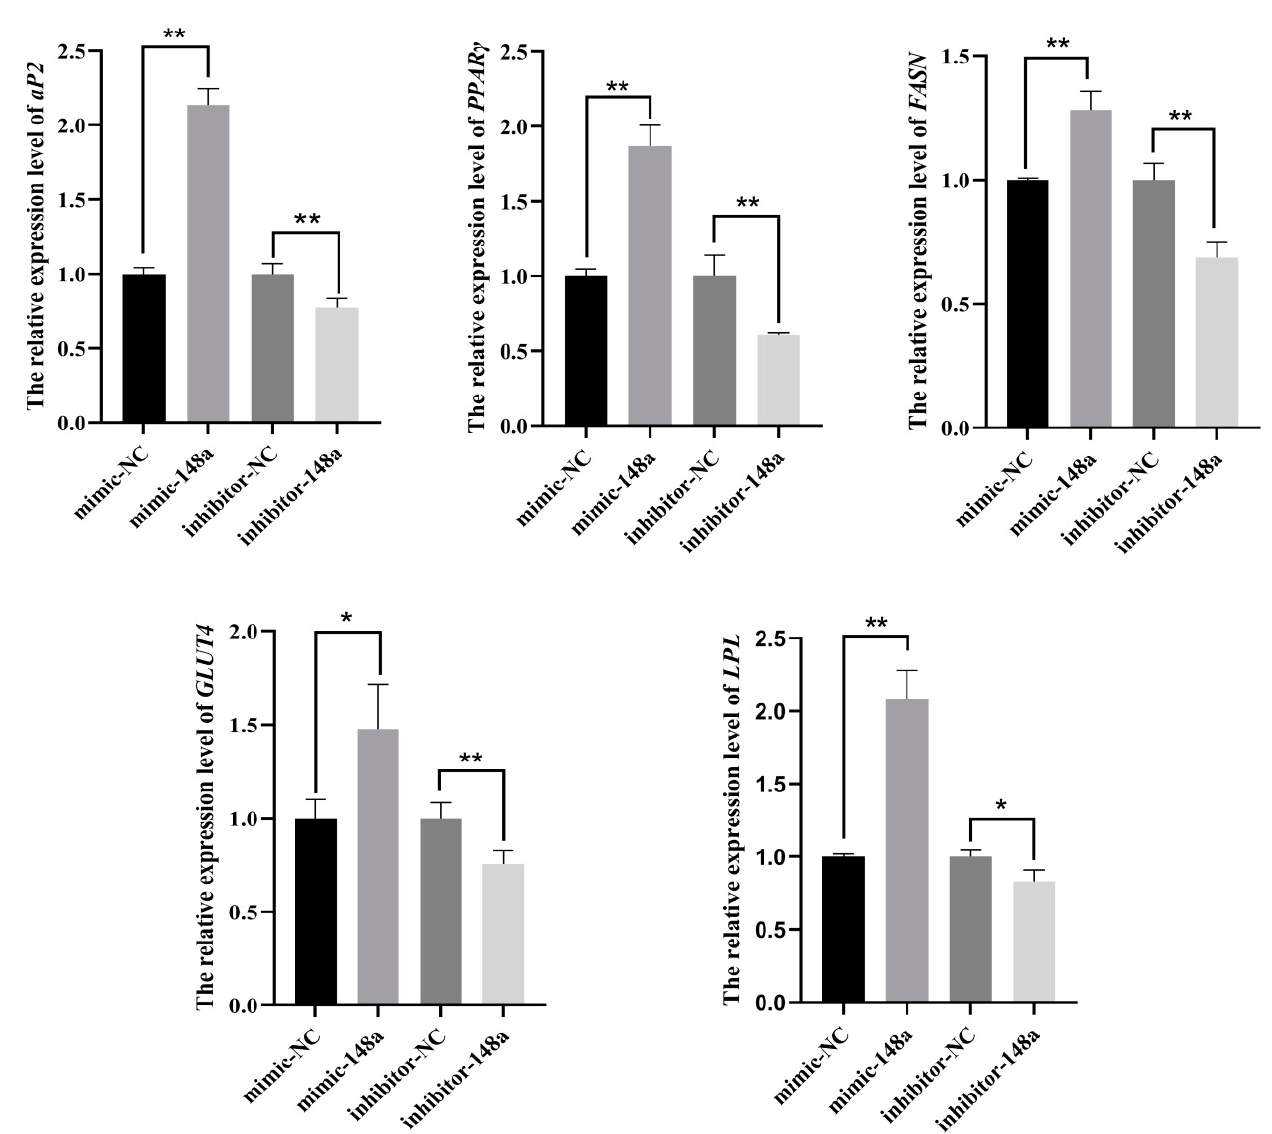
Figure 3. The miR-148a enhances preadipocyte differentiation. When miR-148a mimic, miR-148a inhibitor and negative control (NC) were transfected into differentiated preadipocytes at 50 nM, the expression levels of aP2 , FASN , PPAR γ , GLUT4 and LPL were performed. The results are depicted as the mean ± SD ( n = 3), * p < 0.05, ** p < 0.01.